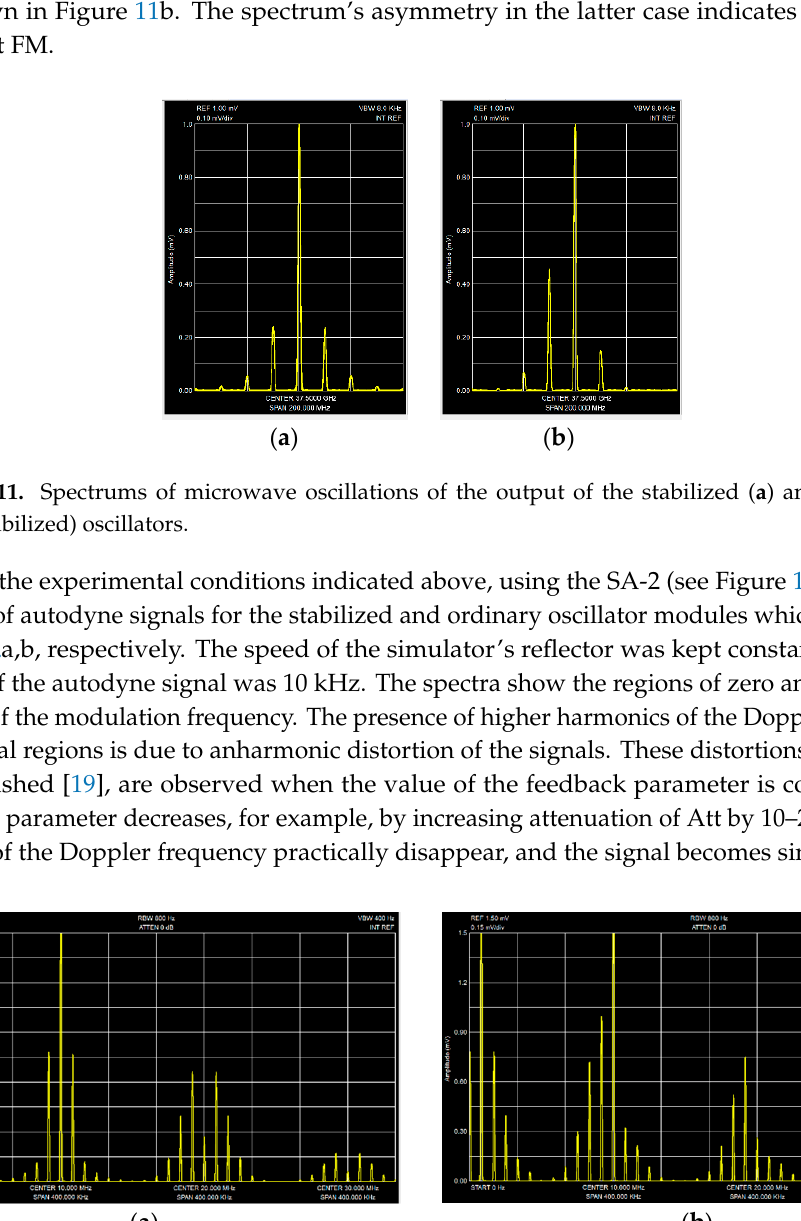
Figure 12. Spectrums of the autodyne signal obtained for the stabilized oscillator in the frequency on the Gunn diode with AM ( a ) and for usual (non-stabilized) oscillator, in which the attended FM is present ( b ).